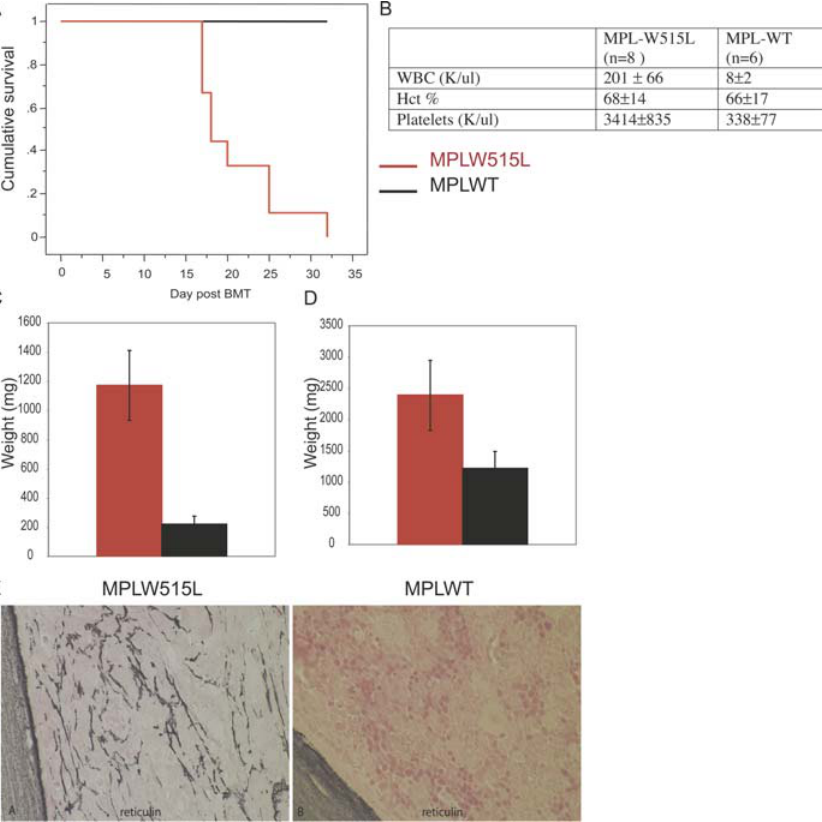
Figure 3. Bone Marrow Transplant with MPLW515L-Transduced Bone Marrow Causes a Rapid Myeloproliferative Disease (A) Kaplan-Meier survival plot of Balb/C mice transduced with MPLW515L ( n ¼ 9) and MPLWT ( n ¼ 6) showing death of all MPLW515L mice between 17 and 32 days post-BMT compared with MPLWT ( n ¼ 6), which were sacrificed for endpoint analysis without evidence of disease. (B) Complete blood counts show leukocytosis and thrombocytosis in MPLW515L BMT model compared with MPLWT. There is no difference in hematocrits. Standard deviation is